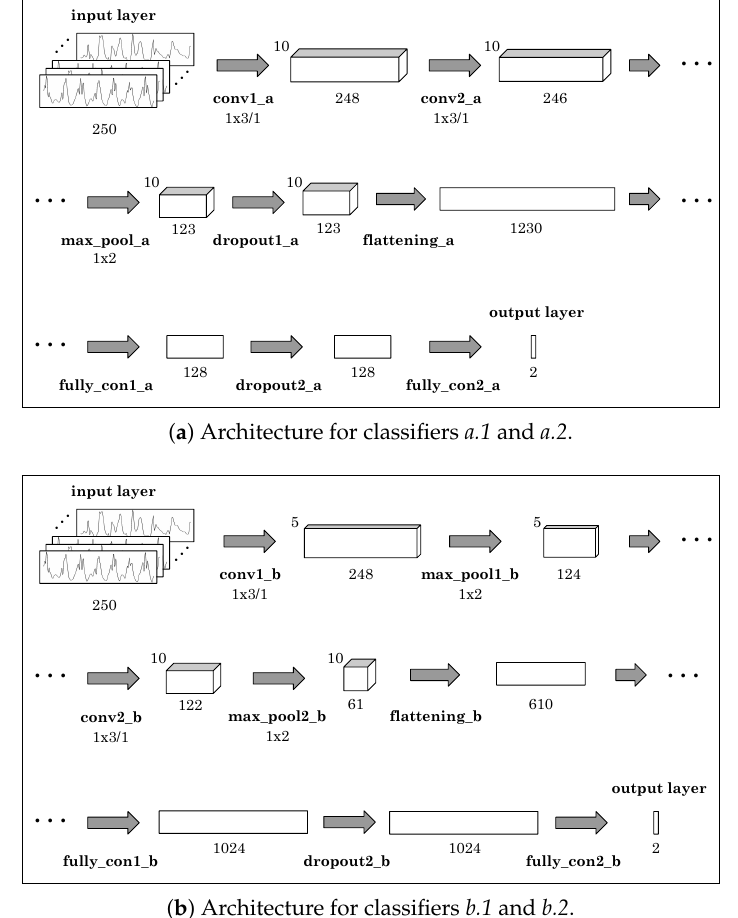
Figure 6. Graphical representation of the two different CNN architectures used in the